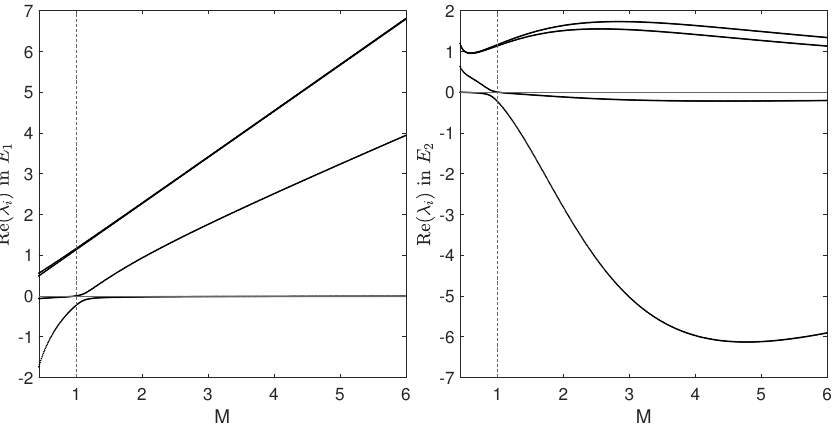
Figure 1. Eigenvalues of the Jacobian J | E with δ = 4, θ = 0.05, Pr = 0.761 which corresponds to ν = − 0.33.